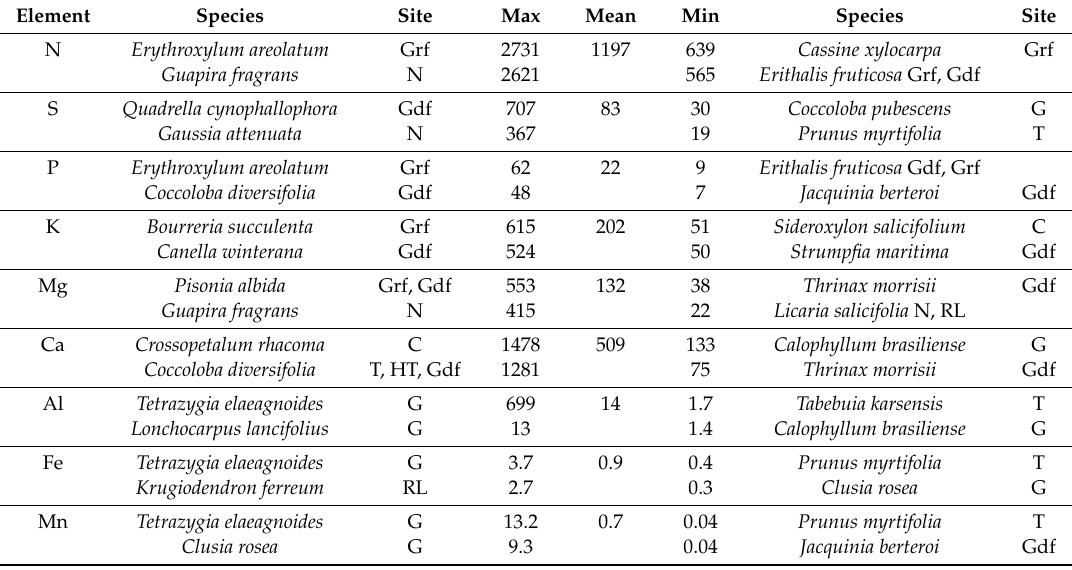
Table 5. Maximum and minimum concentrations of elements (mmol/kg).